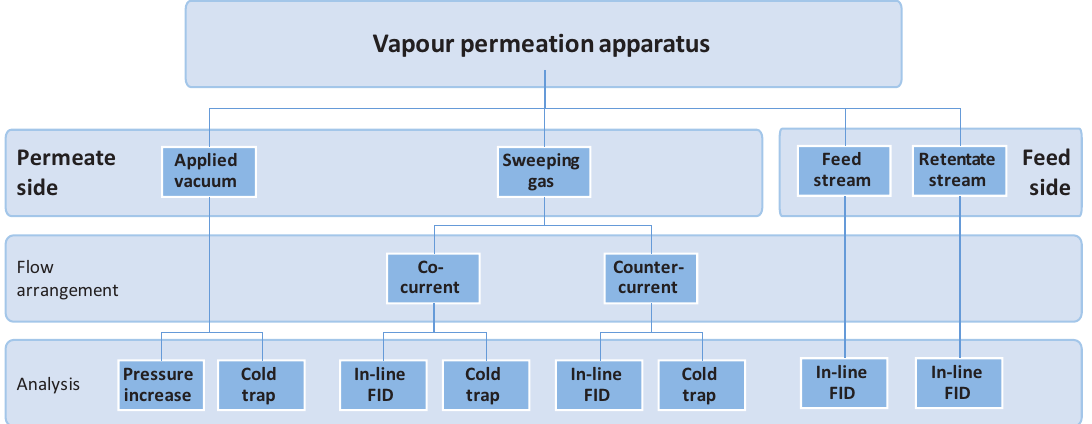
Fig. 2 – Scheme of possible experimental modes of vapour permeation